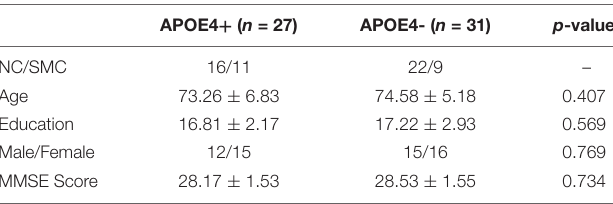
TABLE 2 | Demographic characteristics of the high-risk (APOE4 + ) and low-risk (APOE4-) groups. APOE4 + ( n = 27) APOE4- ( n = 31) p